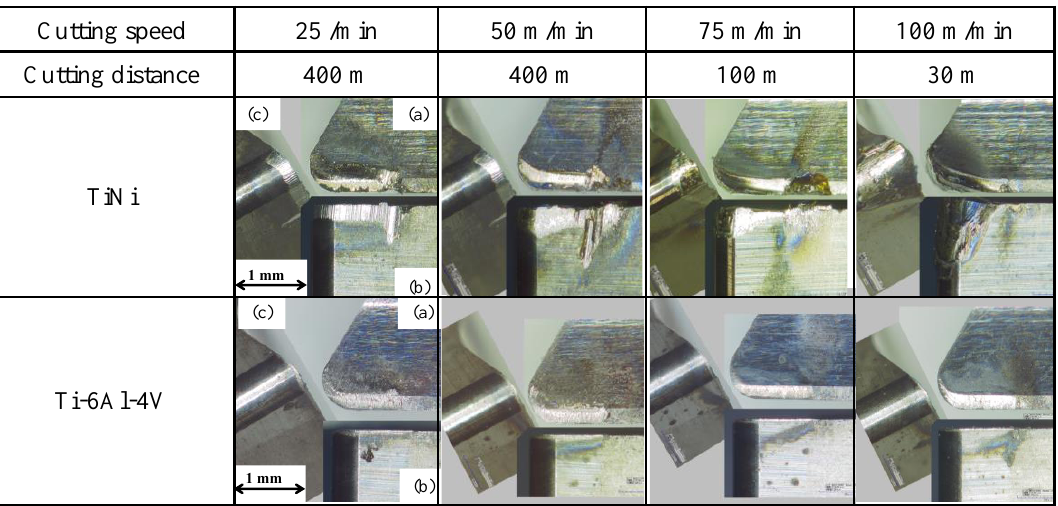
Figure 5. Pictures of tool wear at different cutting speeds and for cutting NiTi and Ti-6Al-4Vs. ( a ) Top view, ( b ) side view, ( c ) tip nose.